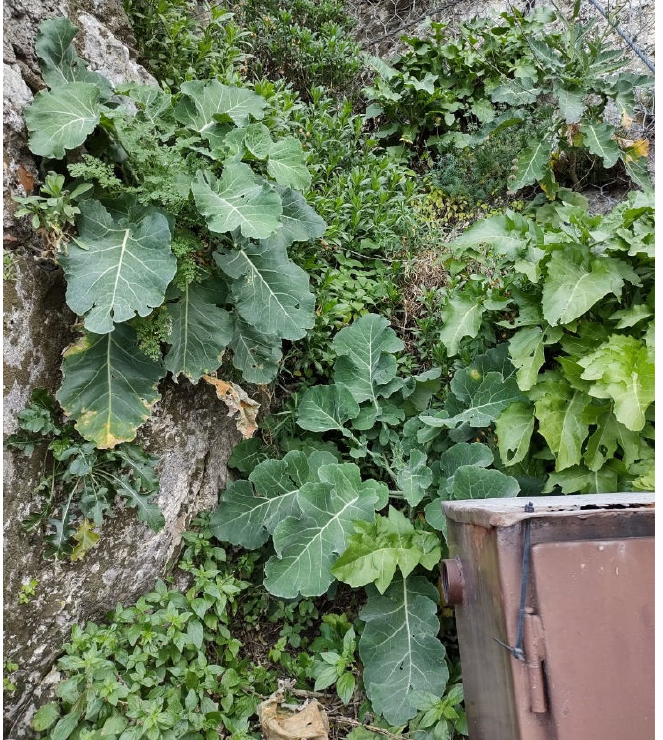
Figure 1. Brassica incana subsp. raimondoi (Sciandr., C. Brullo, Brullo, Giusso, Miniss. and Salmeri) Raimondo and Spadaro in the respective locus classicus (Castelmola, Messina, Italy). It is an about 120 cm tall, stout, often branched suffruticose plant, easily identifiable by the firm, light thickened, green-colored lush leaves or by the white color of the large flowers during the flowering season from March to May, while the fruits arise from June to July. Brassica raimondoi was reported as a Critically Endangered species according to the criteria of the IUCN Red list due to the small population (<100) and area of distribution